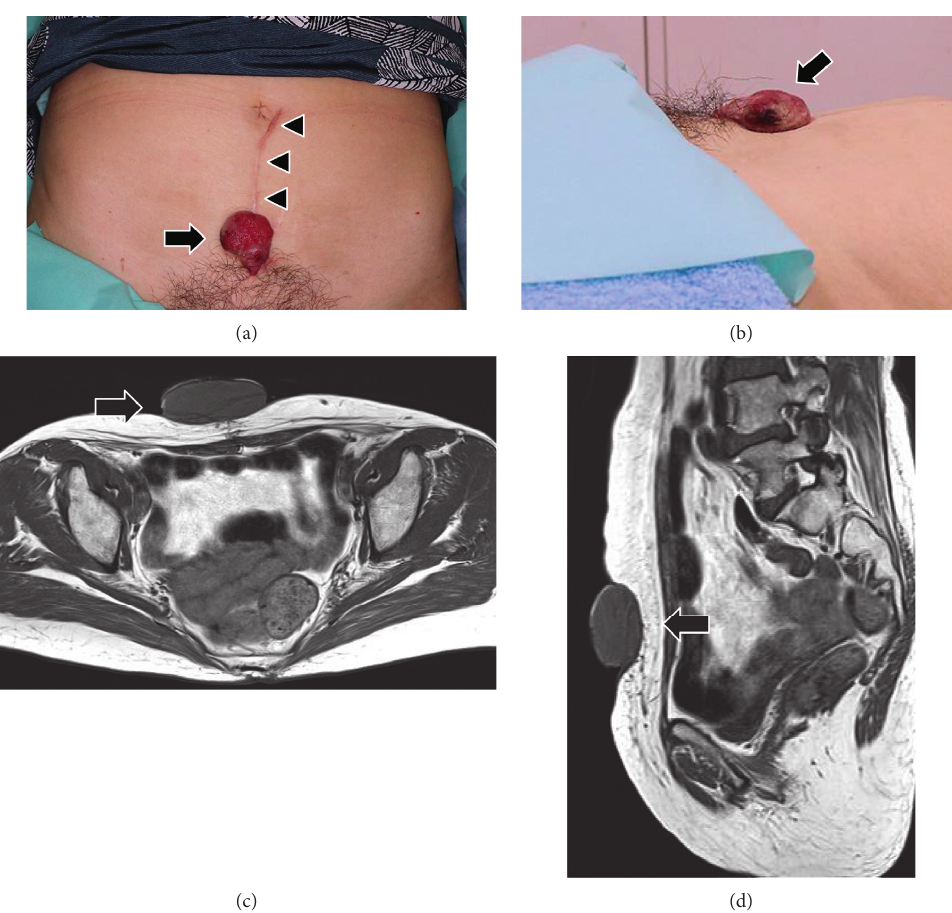
Figure 1: Frontal (a) and lateral (b) view of the large protruding tumor (arrow) located on the abdominal wall. The lesion measured 3 × 3 × 2cm at the first visit. A keloid scar (arrowhead) is visible on the abdominal wall due to partial resection of endometrial cancer. Axial (c) and sagittal (d) view of magnetic resonance imaging revealing a tumor protruding subcutaneously with no continuity to the abdominal cavity